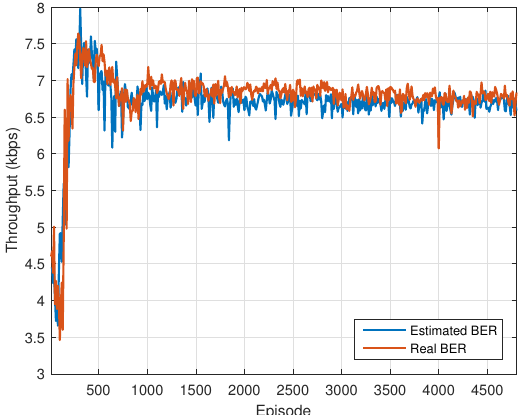
Figure 10. The throughput convergence of the proposed DDQN scheme based on the real BER and estimated